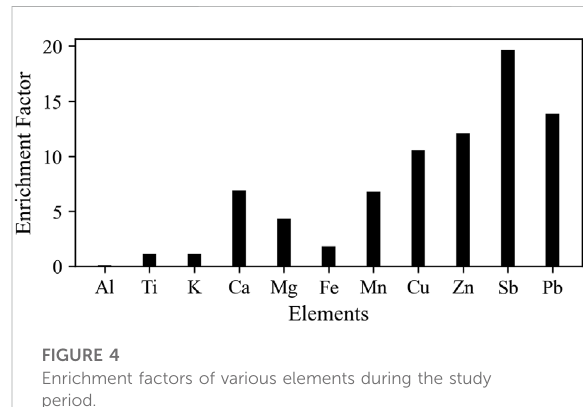
Enrichment factors of various elements during the study